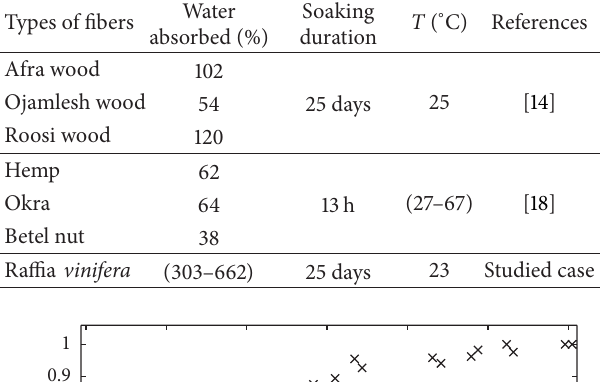
Table 2: Comparison of water absorbed of some natural fibres. Types of fibers